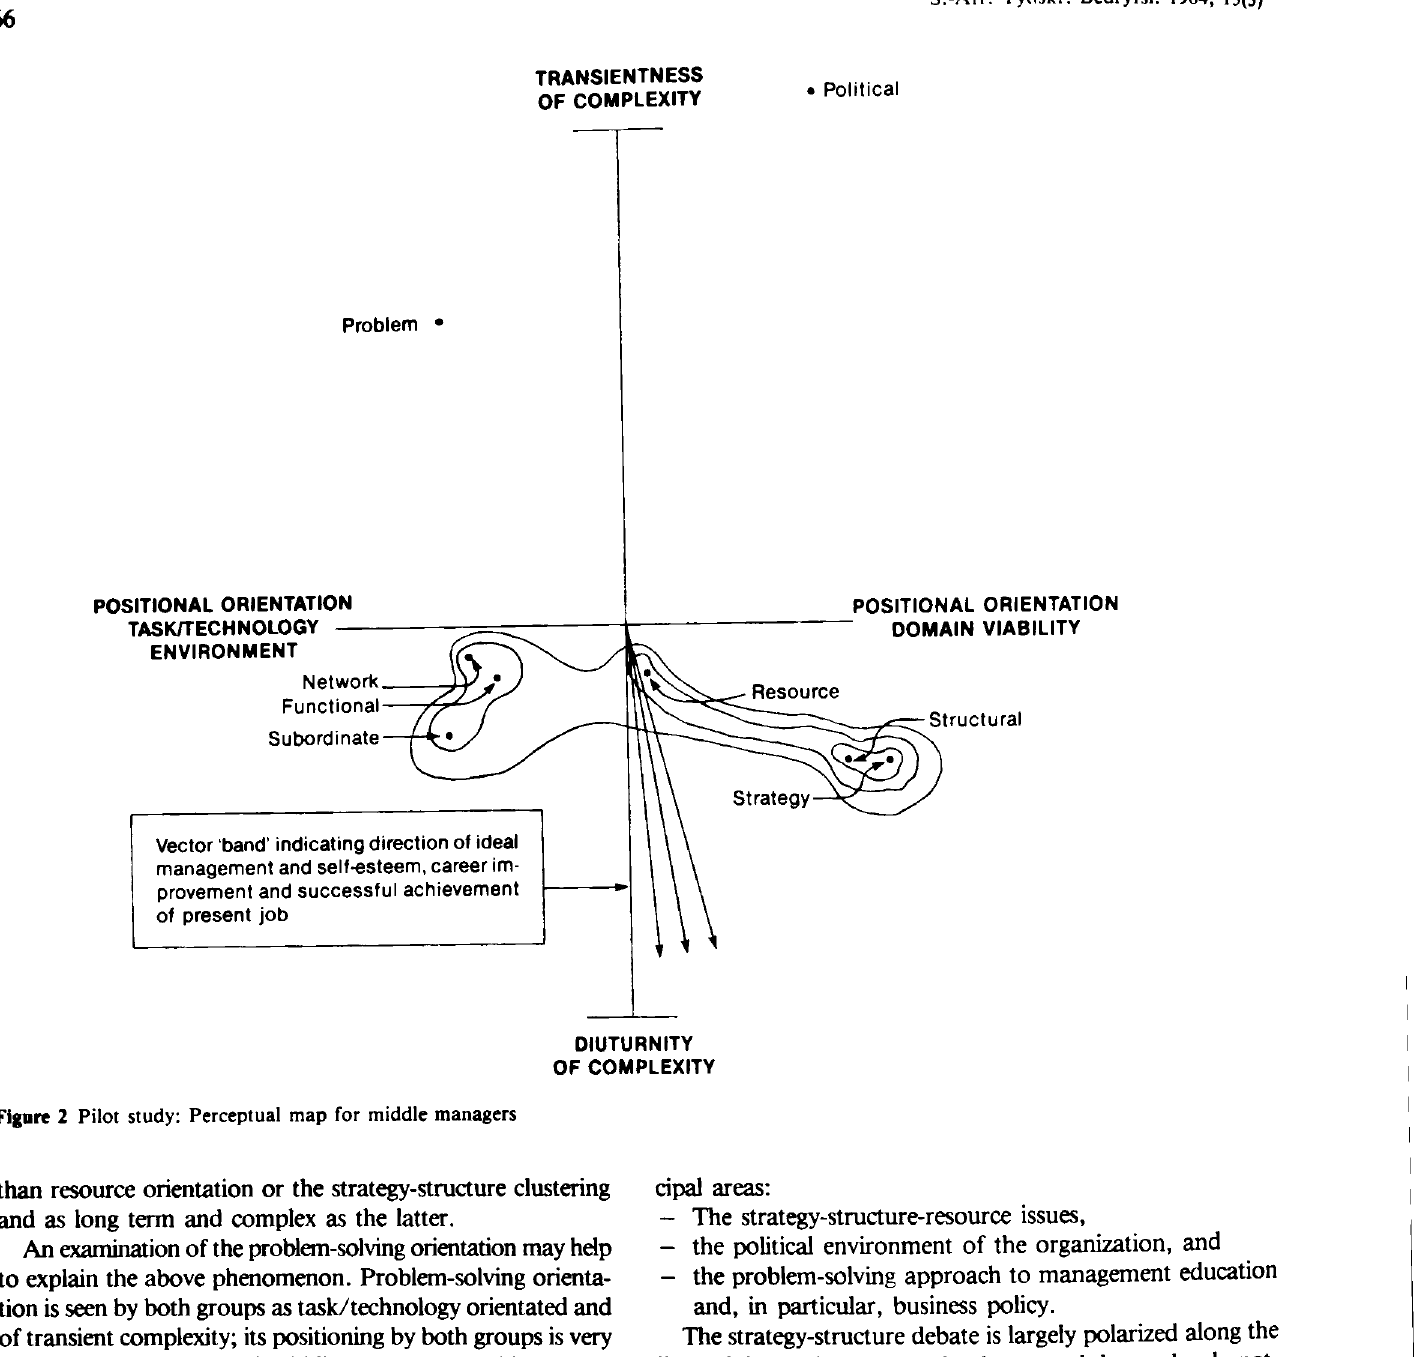
DIUTURNITY OF COMPLEXITY